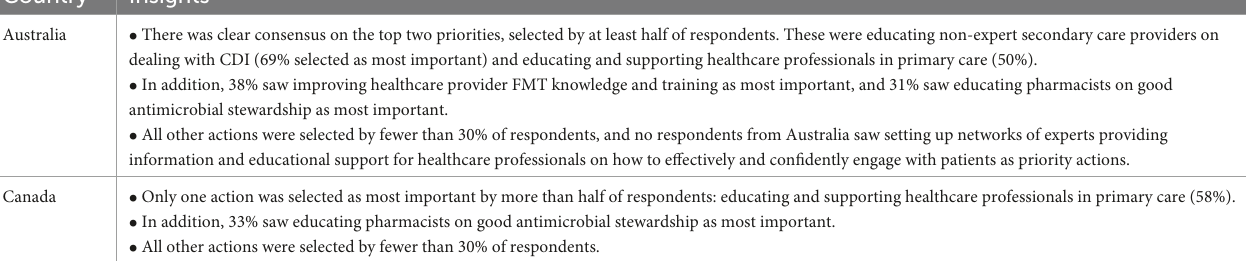
TABLE 8 Country-level insights relating to education and awareness raising of clinician’s priorities. Country Insights